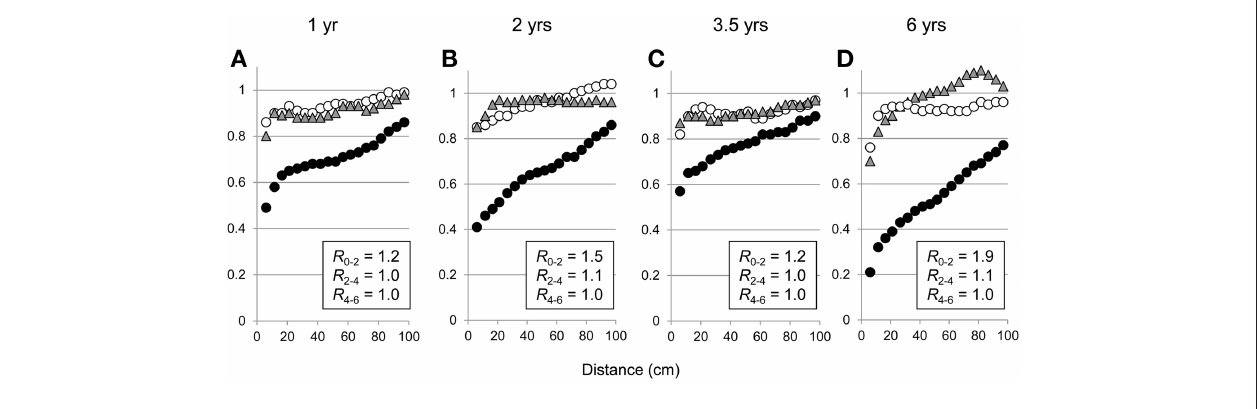
FIGURE 6 | Standardized variograms of fine root intersects in soil layers 0–2m (filled circles), 2–4m (filled gray triangles), and 4–6m (empty circles) for the P0 soil profile in 1-, 2-, 3.5-, and 6-year-old stands on a